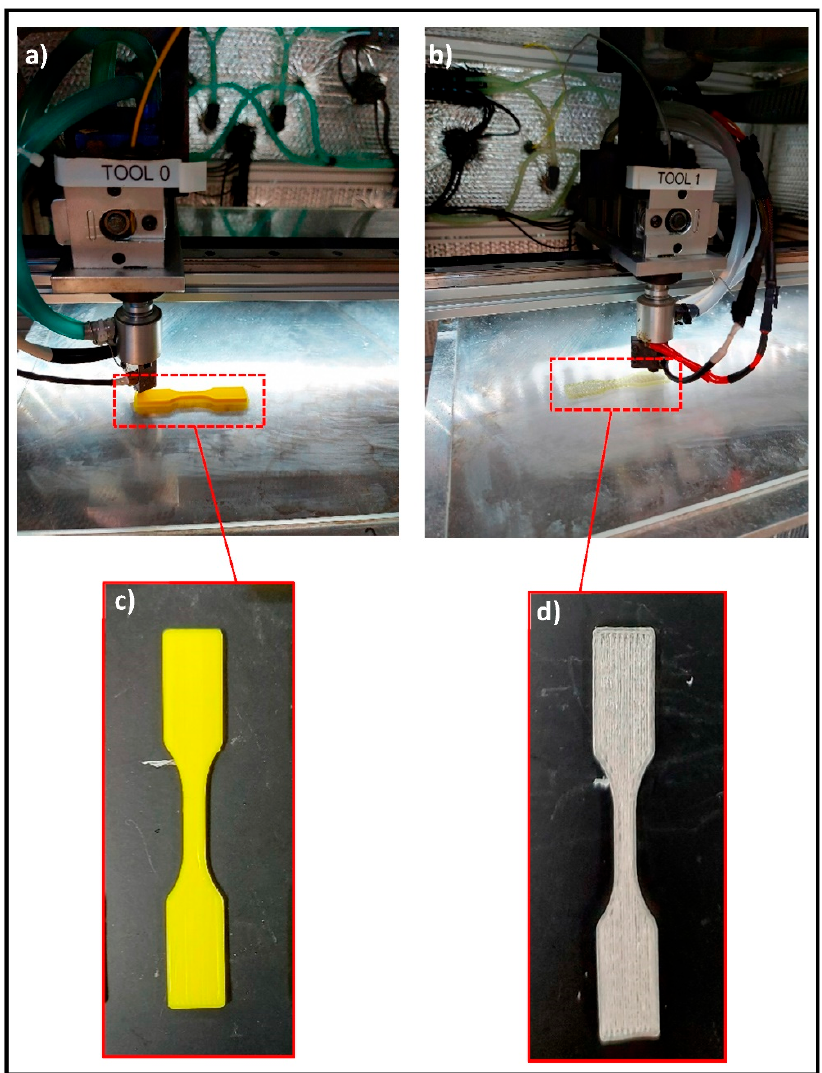
Figure 2. FDM process of tensile bars of ( a ) PLA and ( b ) TCP–PLA. The printed tensile bars of ( c ) PLA and ( d ) TCP–PLA.